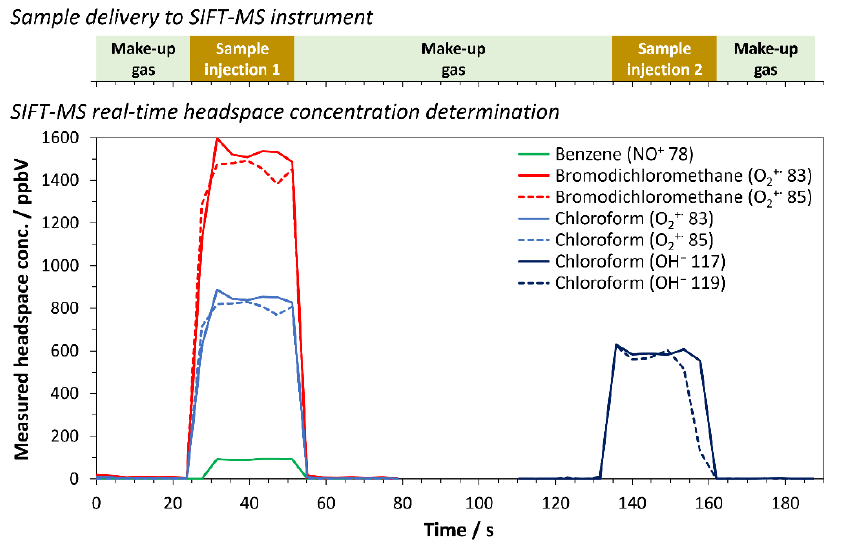
Figure 1. Injections for dual sampling of a single vial (calibration levels of 5 and 50 µ g L − 1 , for BTEX and the THMs, respectively), enabling SIFT-MS analysis using both positive (left-hand injection) and negative (right-hand) reagent ions in a single run. Each trace represents real-time measurement of a given quantitation ion, with benzene, bromodichloromethane, and chloroform product ions used as examples.